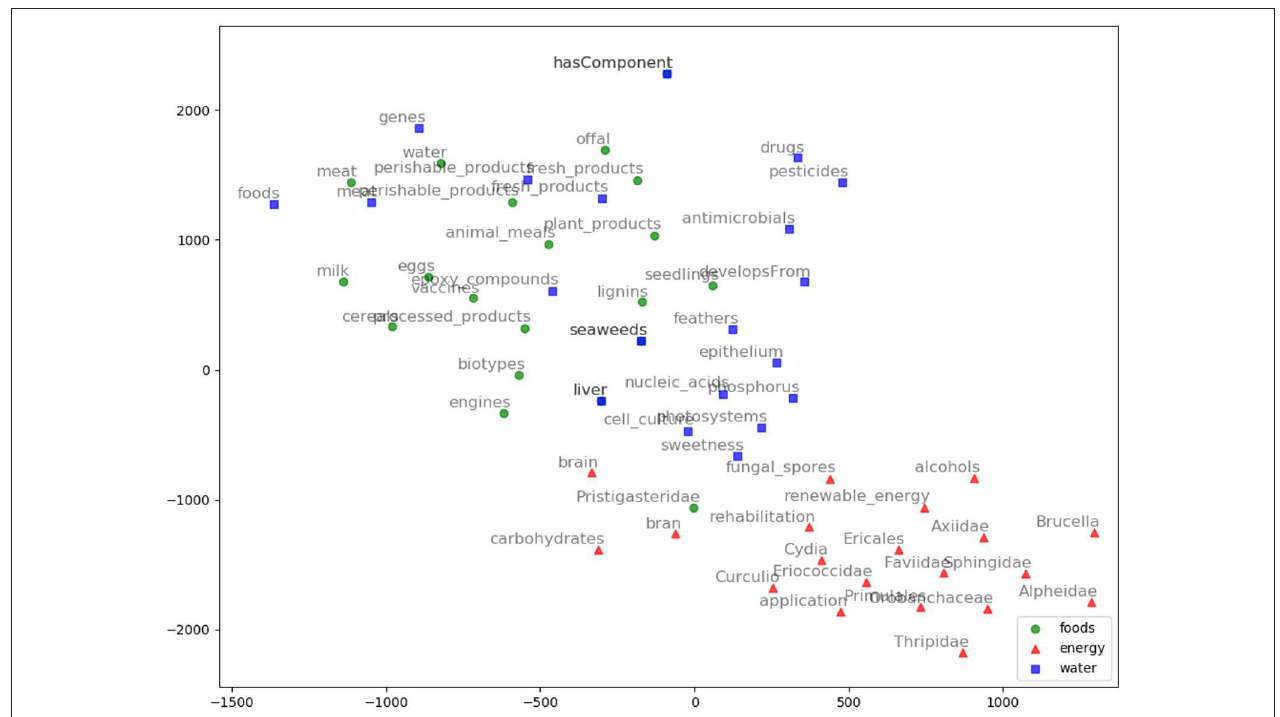
FIGURE 6 | GloVe embeddings visualization using TSNE for the words: Food, Energy, and Water with their top 20 nearest neighbors based on GloVe model.